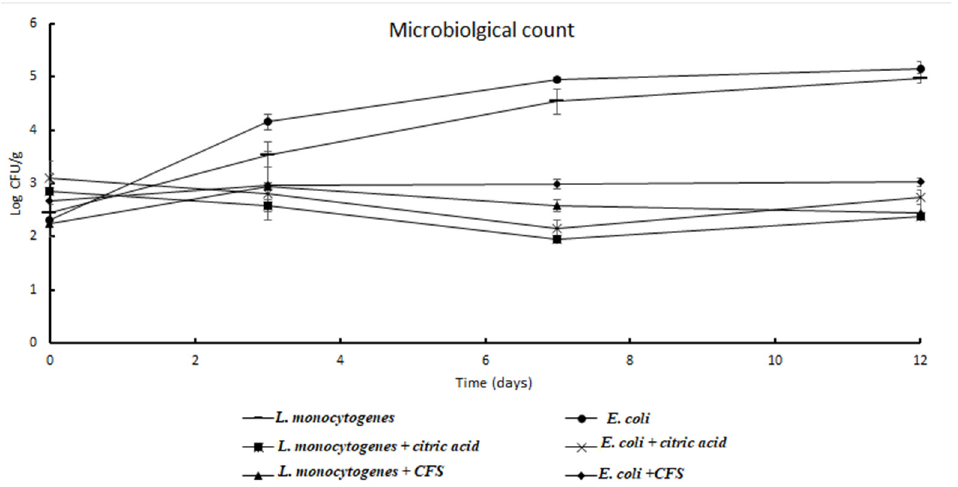
Figure 5. L. monocytogenes and E. coli counts in pomegranate aril samples were differently treated during storage at refrigerated conditions.